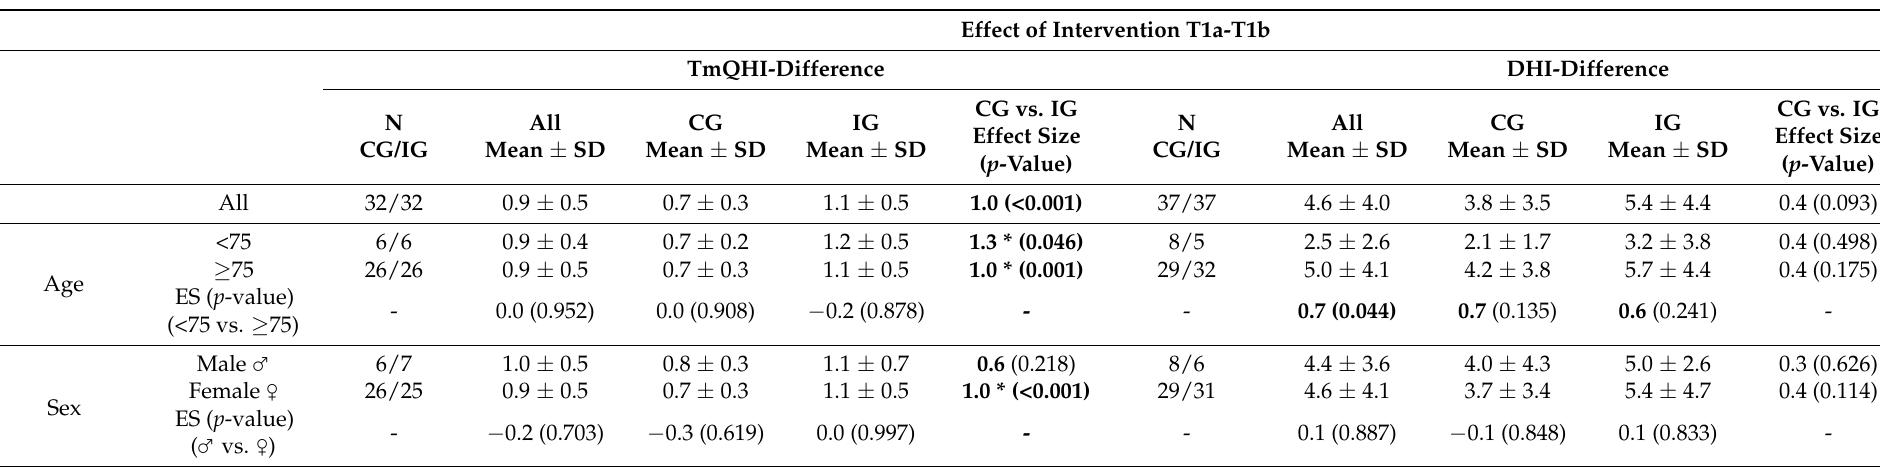
Table 4. Plaque reduction and effect of intervention measured by the TmQHI and the DHI between T1a and